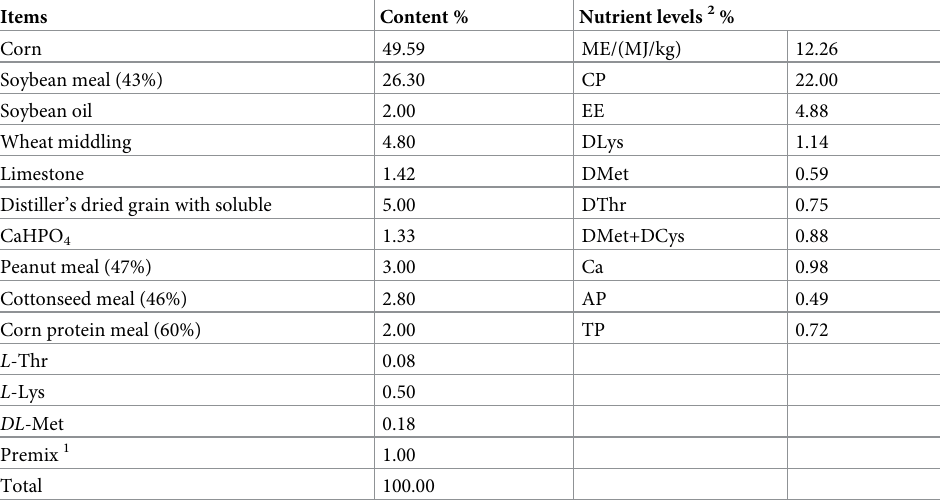
Table 1. Composition and nutrient levels of basal diets (air-dry basis) for broilers aged 1 to 3 wks. Items Content % Nutrient levels 2 % Corn